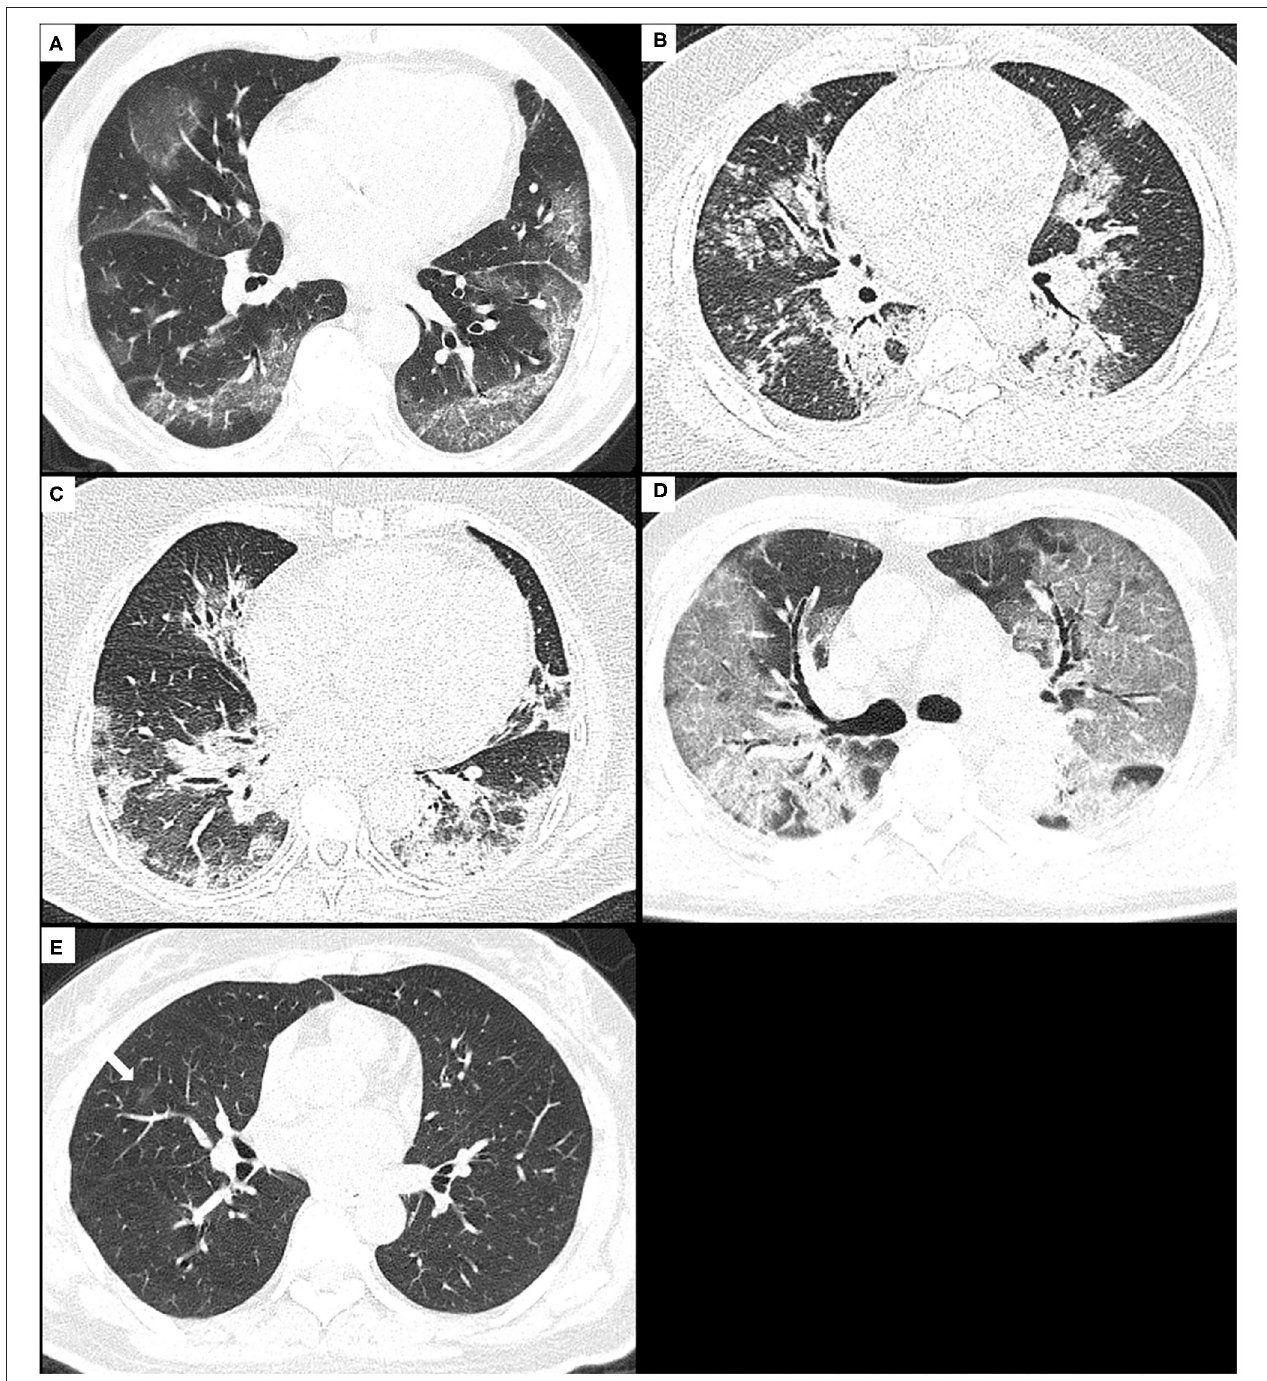
FIGURE 2 | The distribution patterns of pneumonia due to COVID-19 or H1N1. (A) A 74-year-old male with COVID-19 pneumonia presents the onset symptom of fever (37.5 ◦ C), and the CT shows GGO with consolidation and crazy-paving sign mainly along subpleural lungs, namely, as a peripheral distribution pattern. (B) A 29-year-old male with H1N1 pneumonia presents the onset symptoms of fever (39.5 ◦ C), cough, and shortness of breath, and the CT shows consolidation and small centrilobular nodules mainly along bronchovascular bundles, namely, as a peribronchovascular distribution pattern. (C) A 59-year-old female with H1N1 pneumonia presents the onset symptoms of fever (38.5 ◦ C), cough, and shortness of breath, and the CT shows consolidation with GGO along bronchovascular bundles and subpleural lungs, namely, as a distribution pattern of both peripheral and peribronchovascular. (D) A 71-year-old male with COVID-19 pneumonia presents the onset symptoms of fever (38 ◦ C) and dyspnea, and CT shows diffuse GGO with consolidation and crazy-paving sign in both lungs, namely, as a diffuse distribution pattern. (E) A 50-year-old female with COVID-19 pneumonia presents the onset symptoms of fever (39 ◦ C) and cough, and CT shows very small non-rounded GGO located in the middle lobe of the right lung lacking a specific distribution. COVID-19, coronavirus disease 2019; GGOs, ground-glass opacities.